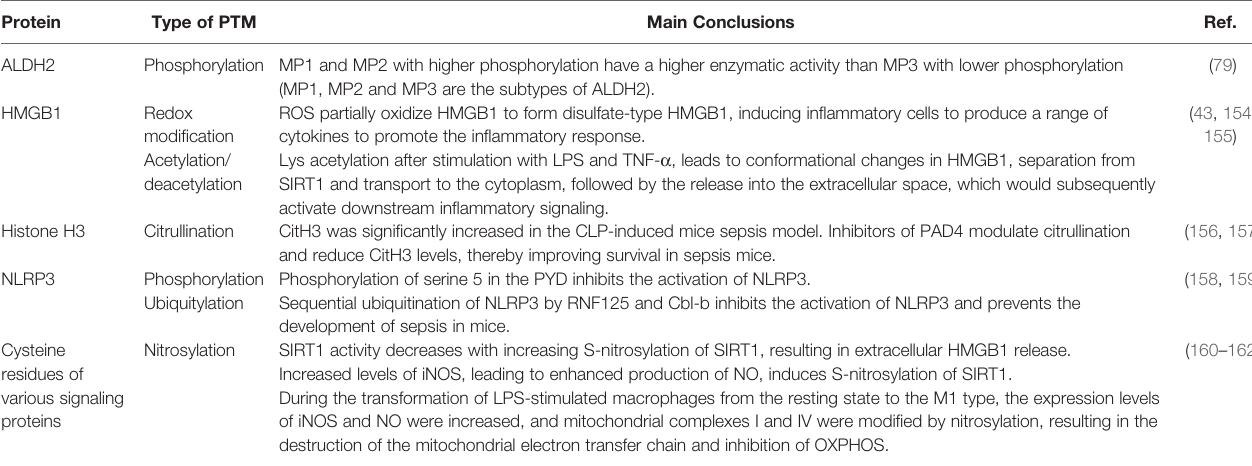
TABLE 3 | Summary of post-translational modi fi cations in sepsis.